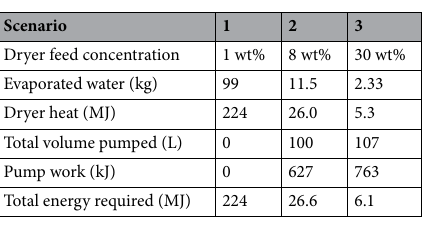
Table 7. The energy requirement calculations, based on 1 kg of sodium acetate, recovered from a 1 wt% solution.